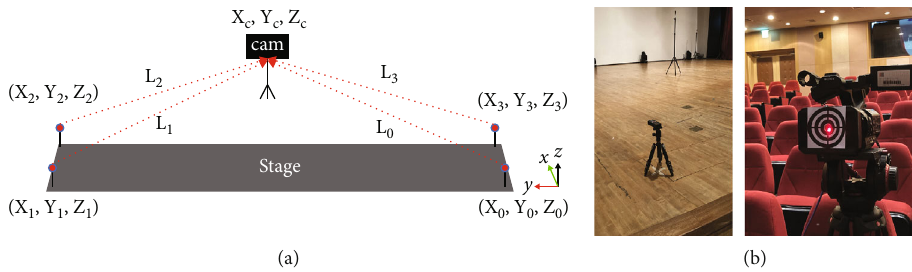
Figure 3: (a) Coordinate system diagram of laser measuring instrument and camera for calibration, (b) measuring distance and angle of camera using laser distance and angle meter. Installation of a laser meter on stage (left) and a laser meter measuring the distance and angle of camera